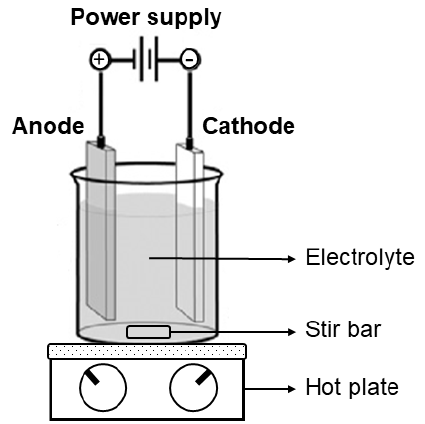
Figure 1. Schematic diagram of the electrolytic cell